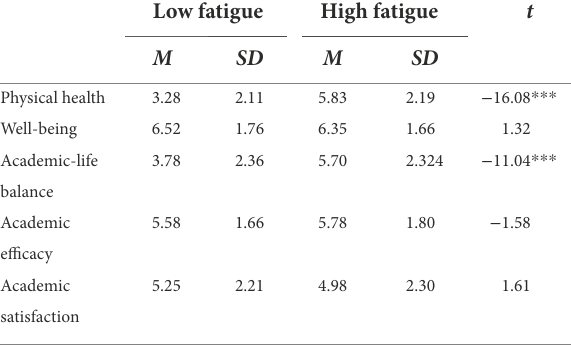
TABLE 3 Individual health outcomes under the different levels of academic